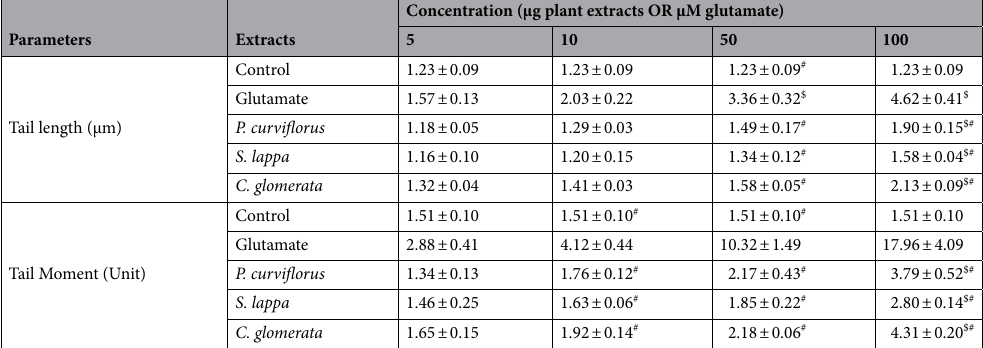
Table 2. Comparison of control cells at various concentrations of glutamate and P. curviflorus ; S. lappa ; and C. glomerate- treated. Comparison among all cell treatments using One-Way ANOVA test with Multiple Comparisons (Dunnett test) to compare each group with the control group. $ p < 0.001, value between each cell group and control cells. # p < 0.001 value between all group.